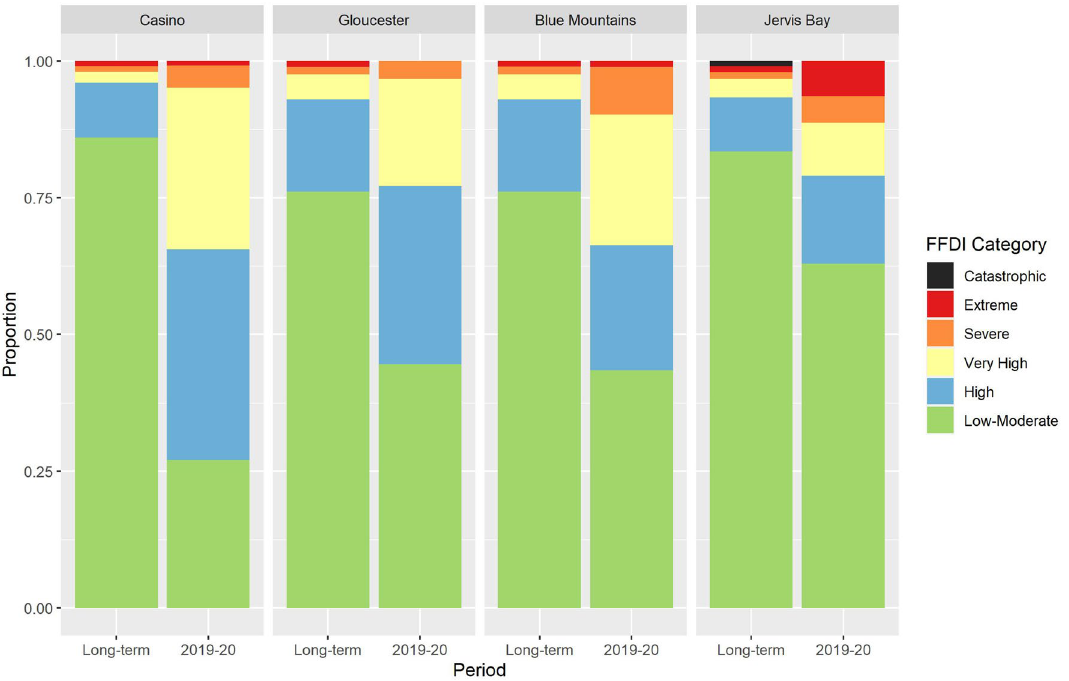
Figure 2.. Relative frequency of FFDI categories from half-hourly weather station data during the long-term record (1995–2014 for Casino, 1991–2014 for Gloucester and Blue Mountains, 2000–2014 for Jervis Bay) and during the 2019–2020 season.